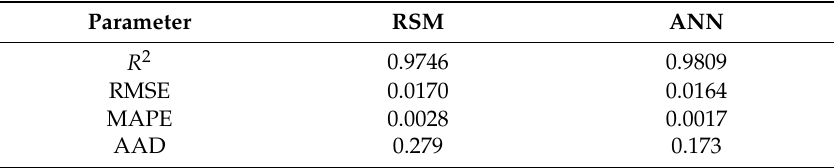
Table 6. Comparison of statistical criteria of